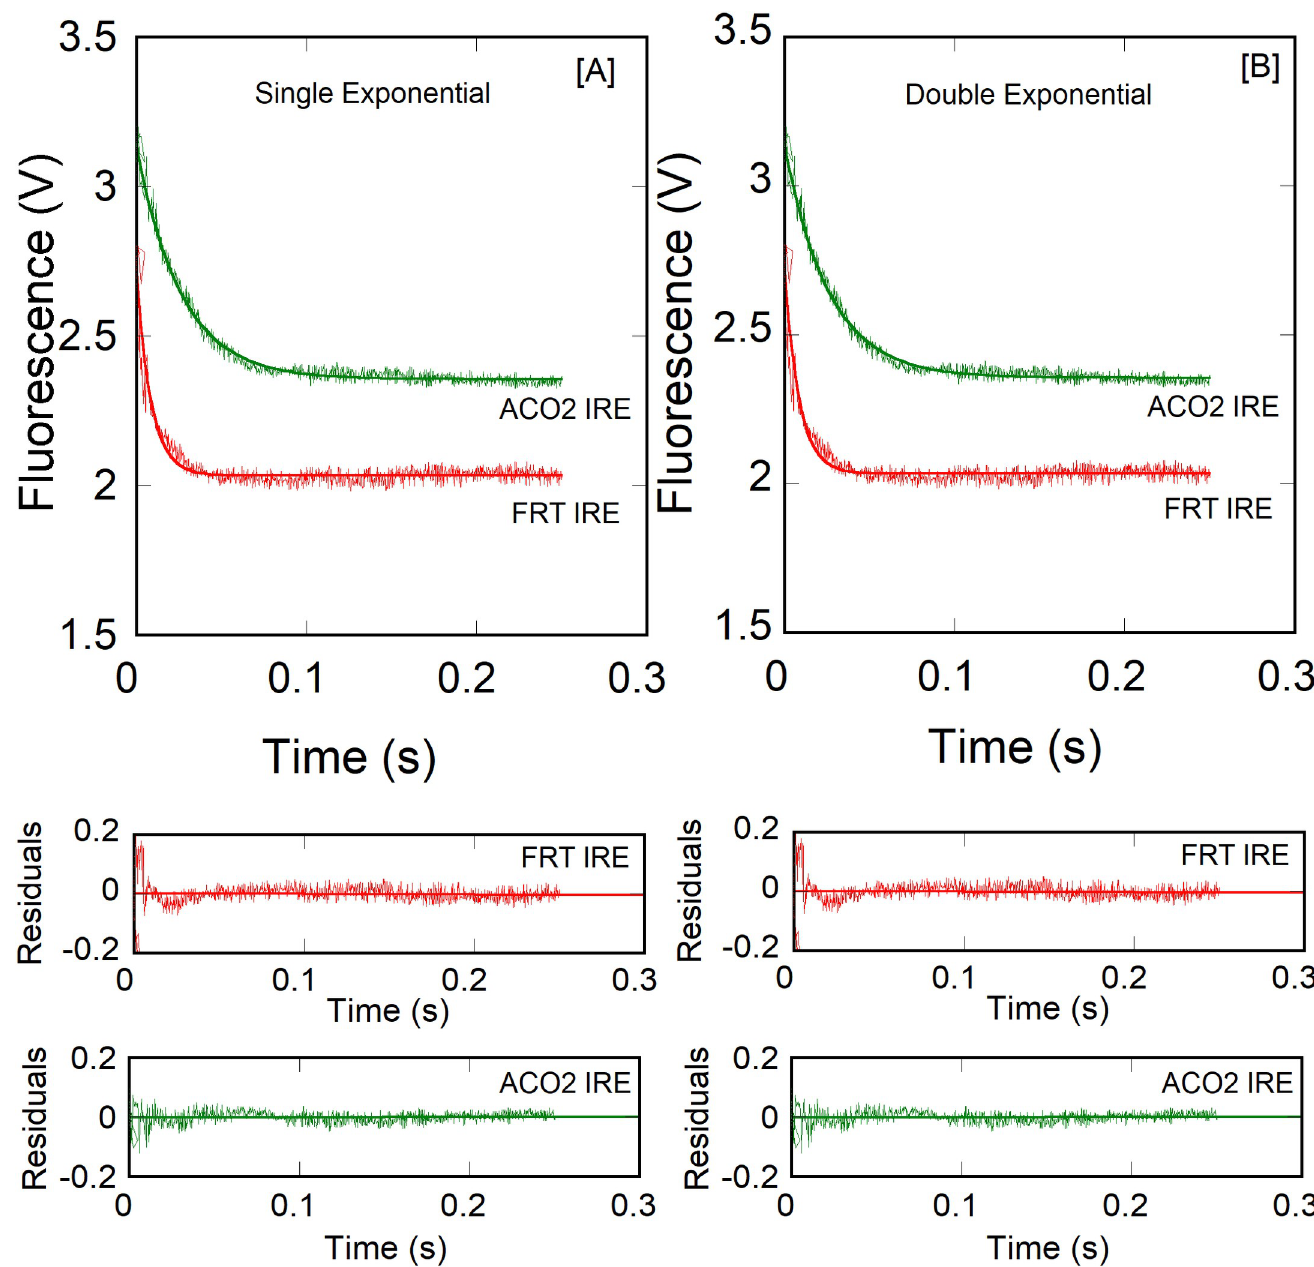
Fig 2. Kinetic analyses of IRE RNA interactions with eIF4F. A solution of 1.0 μ M (after mixing) FRT (or ACO2 IRE RNA) was rapidly mixed with 0.1 μ M (after mixing) eIF4F at 20 ˚C. (A) Single-exponential fit to the kinetic data. (B) Double-exponential fit to the same kinetic data as in panel (A). A double exponential fit did not improve the fitting. Solid lines represent the fitted curve drawn through the data points and were best fit by assuming a single-exponential fit. Fluorescence is measured in volts (V). Residuals for the corresponding fits are shown in the lower panels . The observed rate constant for FRT and ACO2 IRE RNA binding to eIF4F were significantly